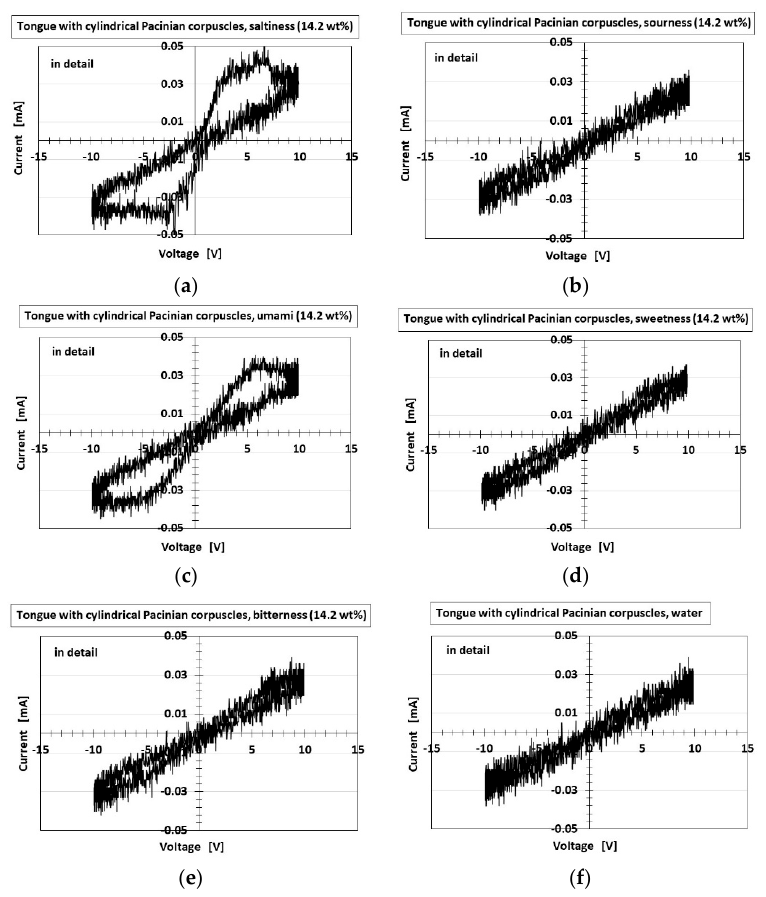
Figure 18. Experimental results of cyclic voltammogram plots for cylindrical Pacinian corpuscles responding to: ( a ) saltiness; ( b ) sourness; ( c ) umami; ( d ) sweetness; ( e ) bitterness; ( f ) water: the right figures are magnified from the left figures.